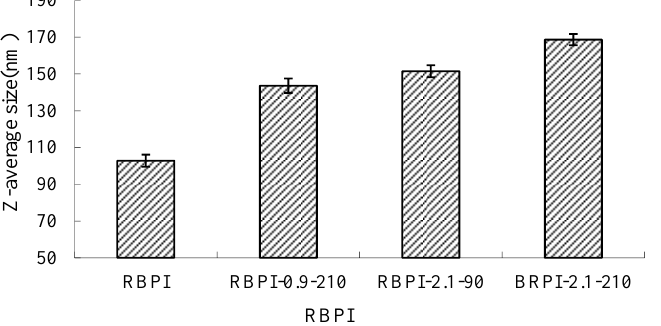
Figure 7. Average size of RBPI prepared from different SFE pretreatment